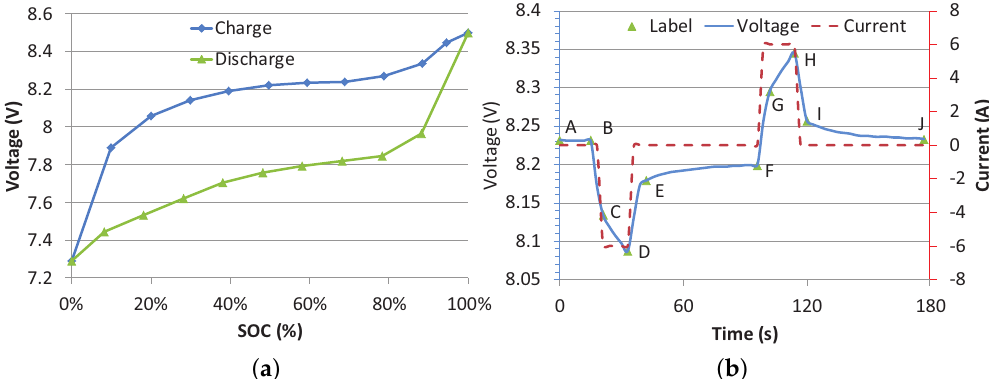
Figure 5. Battery characteristics under OCV and HPPC test. The left in the figure is curve of OCV test, the right side is curve of HPPC test. Test conditions are listed as: ( a ) At the constant temperature environment of 15 degrees Celsius, 6A charge and discharge current is test conditions for HPPC. ( b ) For OCV, test conditions is under a constant temperature environment of 25 degrees Celsius, charge and discharge current of 0.5C, lay aside for three hours. Test equipment is battery tester Series4000 from MACCOR (Tulsa, OK, USA).